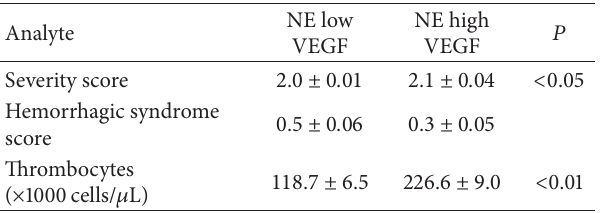
Table 8: Severity score based on serum VEGF (high > 93 pg/mL; low < 93